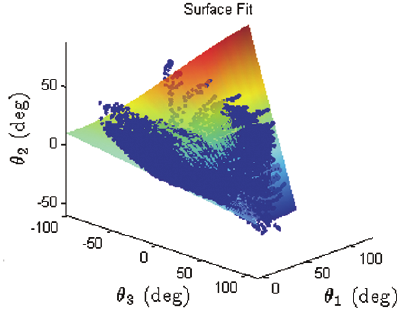
Fig. 12. To visualize the deployment envelope, the body point’s x coordinate in JCS is preserved as x ′ while the circumference to the point is used as z ′